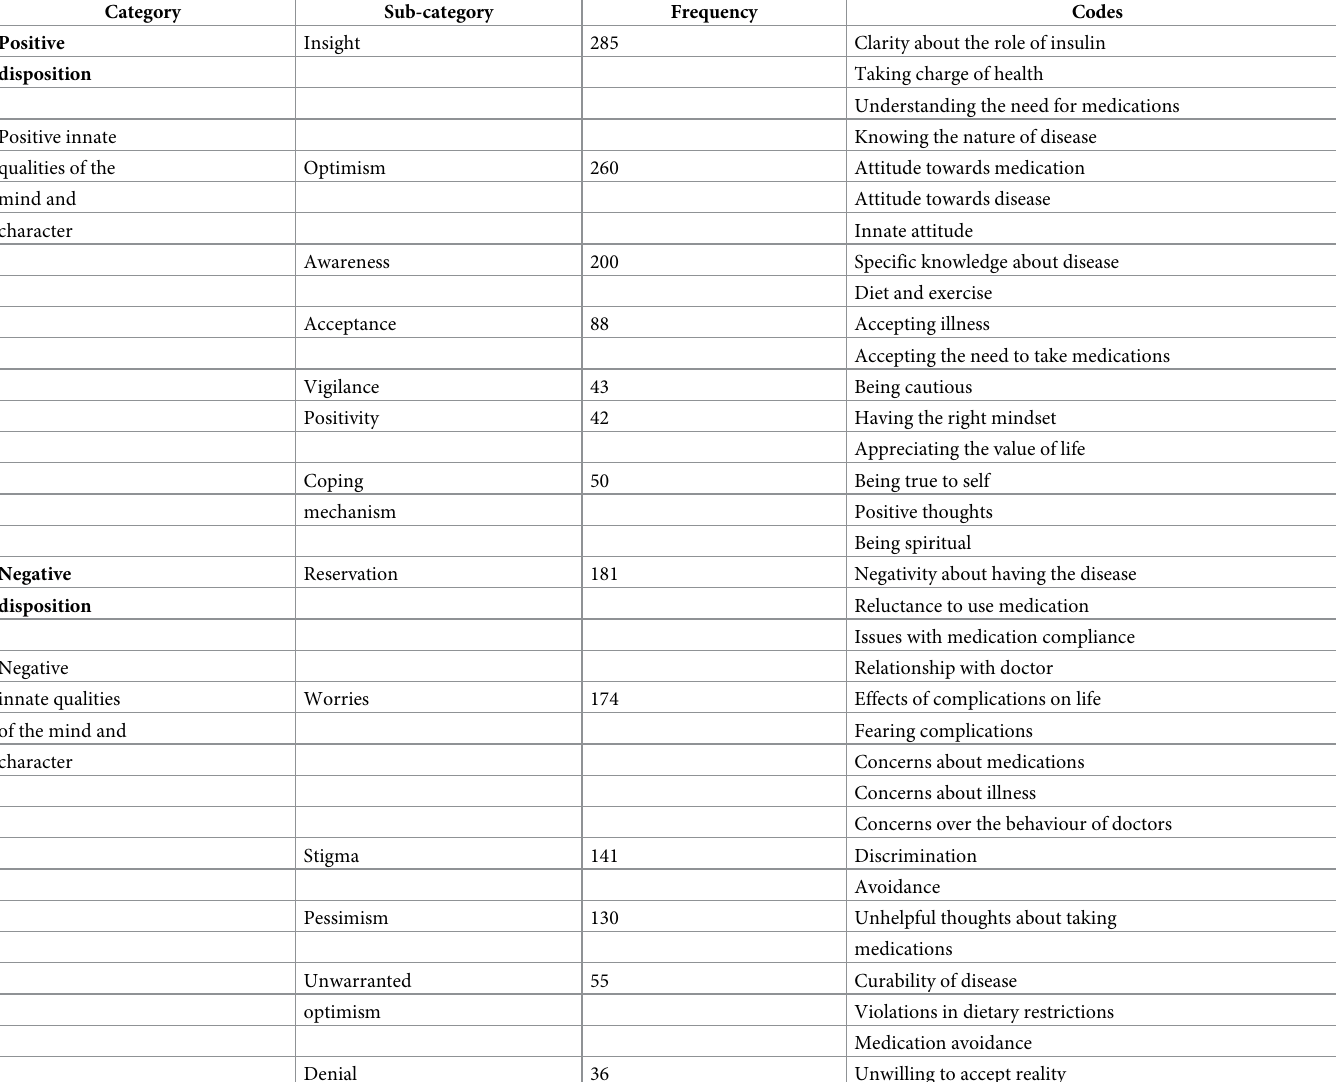
Table 3. Categories, definitions, frequency, and codes describing the personal disposition of individuals with